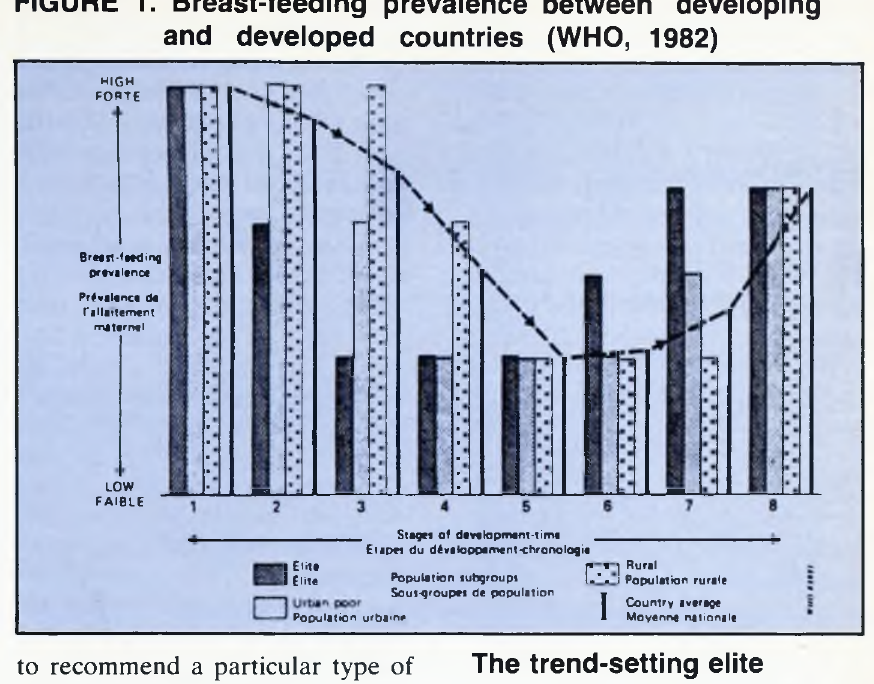
FIGURE 1. Breast-feeding prevalence